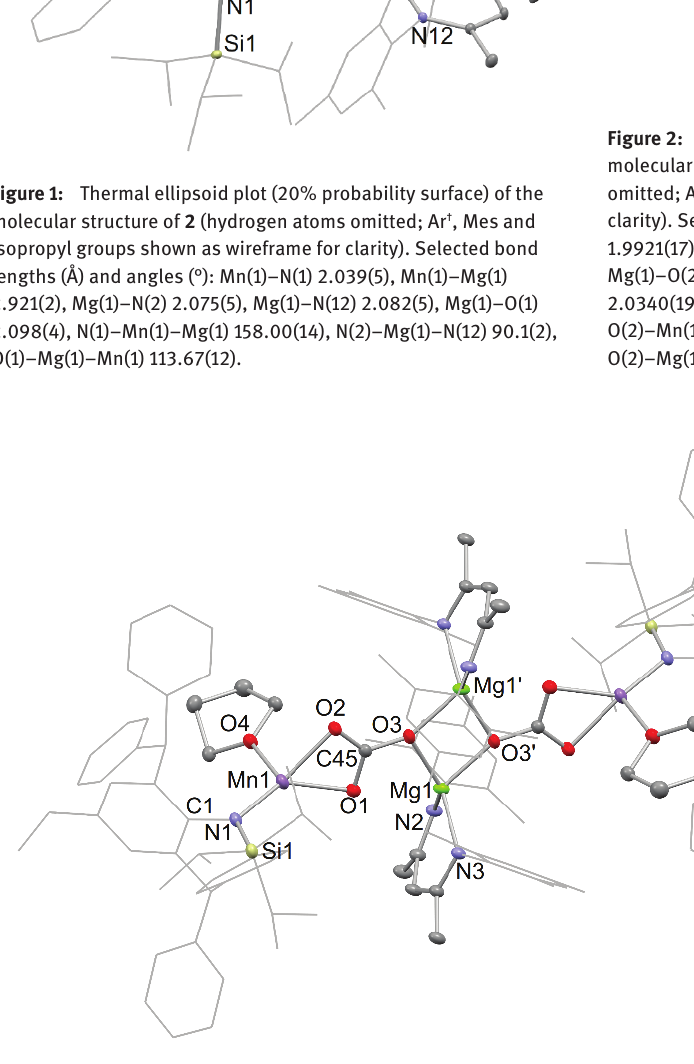
Figure 3: Thermal ellipsoid plot (20% probability surface) of the molecular structure of 4 (hydrogen atoms omitted; Ar † , Mes and isopropyl groups shown as wireframe for clarity). Selected bond lengths (Å) and angles (°): Mn(1)–N(1) 1.997(3), Mn(1)–O(4) 2.120(3), Mn(1)–O(2) 2.140(3), Mn(1)–O(1) 2.167(3), Mg(1)–O(3)’ 1.991(3), Mg(1)–O(3) 2.017(3), O(1)–C(45) 1.293(5), O(2)–C(45) 1.253(5), O(3)–C(45) 1.289(5),